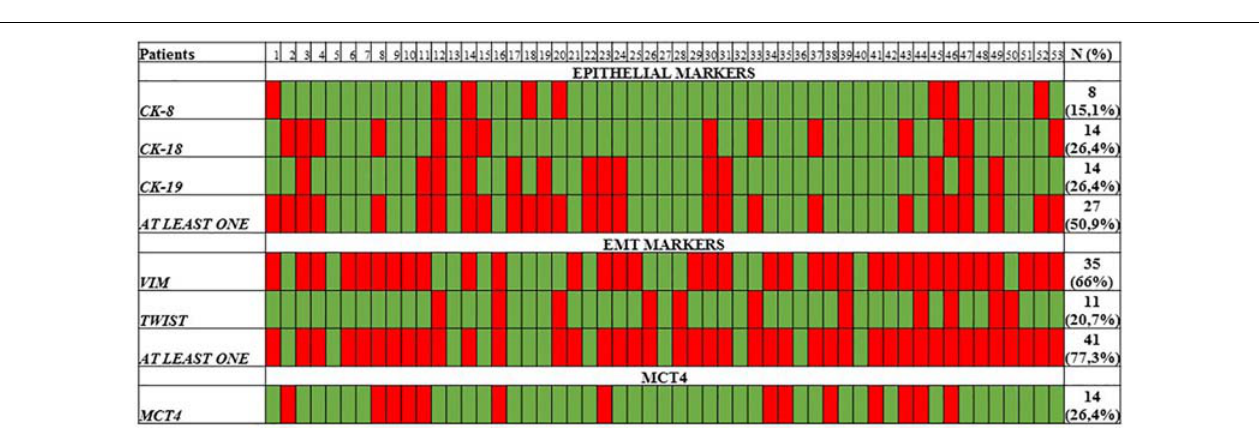
FIGURE 1 | Outline of the experimental procedure. (A) Gene expression profiling of CTCs. (B) Phenotypic evaluation of CTCs.